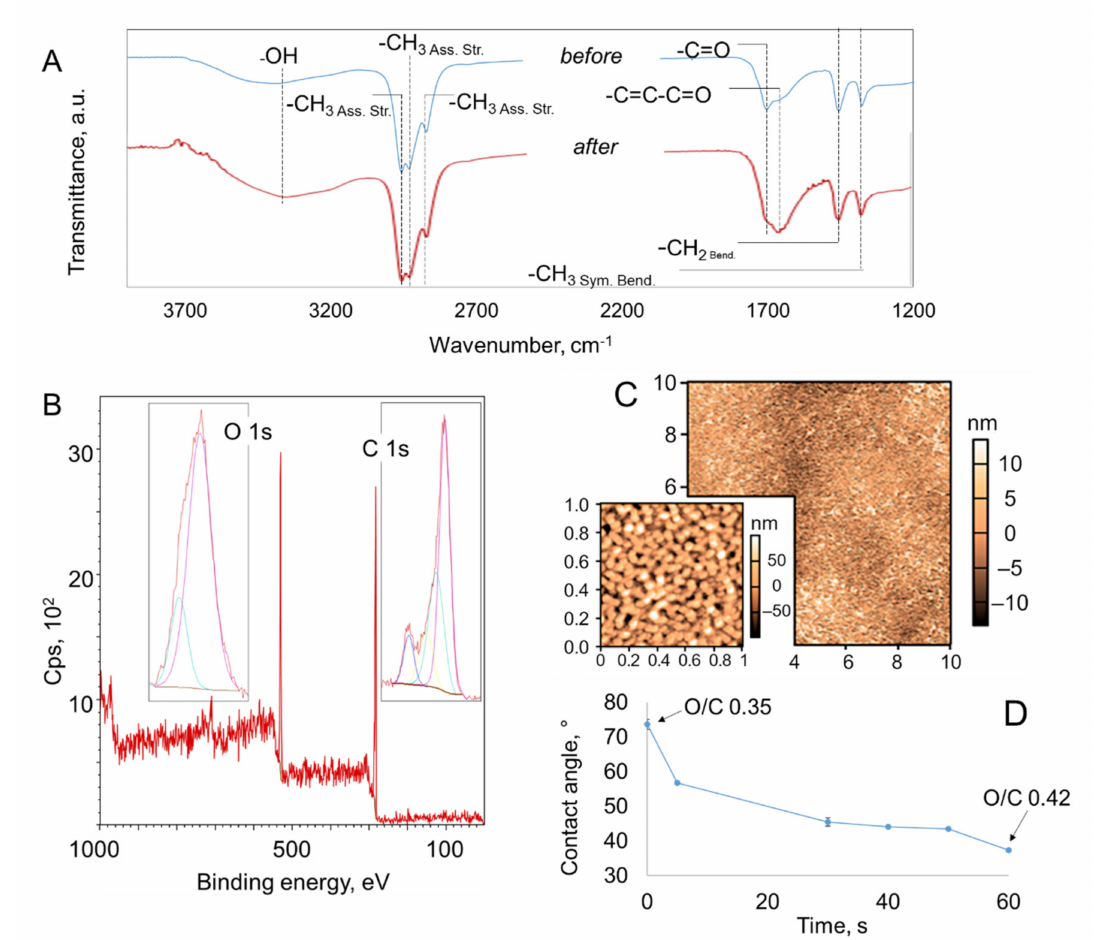
Figure 3. Effect of 60 s of direct exposure to Ar plasma on polymer coating fabricated at 15 W on PET. ( A ) FTIR spectra before and after treatment. ( B ) A typical XPS wide scan spectrum of treated polymer coating. Inset: high resolution spectra for oxygen and carbon. ( C ) AFM images after treatment. Scan size 10 × 10 µ m. Inset scan size 1 × 1 µ m. ( D ) Contact angle evolution as a function of treatment time. Oxygen to carbon ratio based on XPS atomic fractions shows an increase in oxygen content within the topmost layer of the polymer